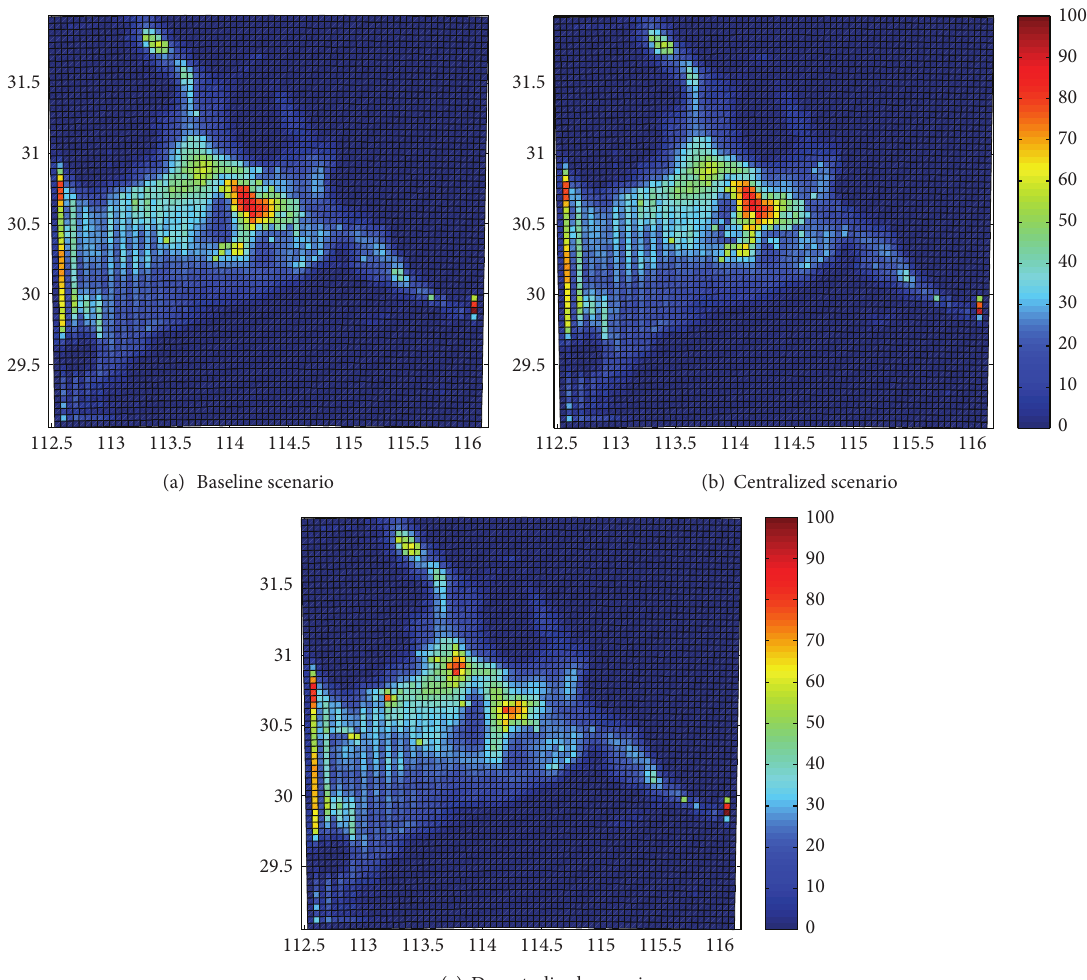
Figure 8: Spatial distribution of precipitation under different scenarios (unit: